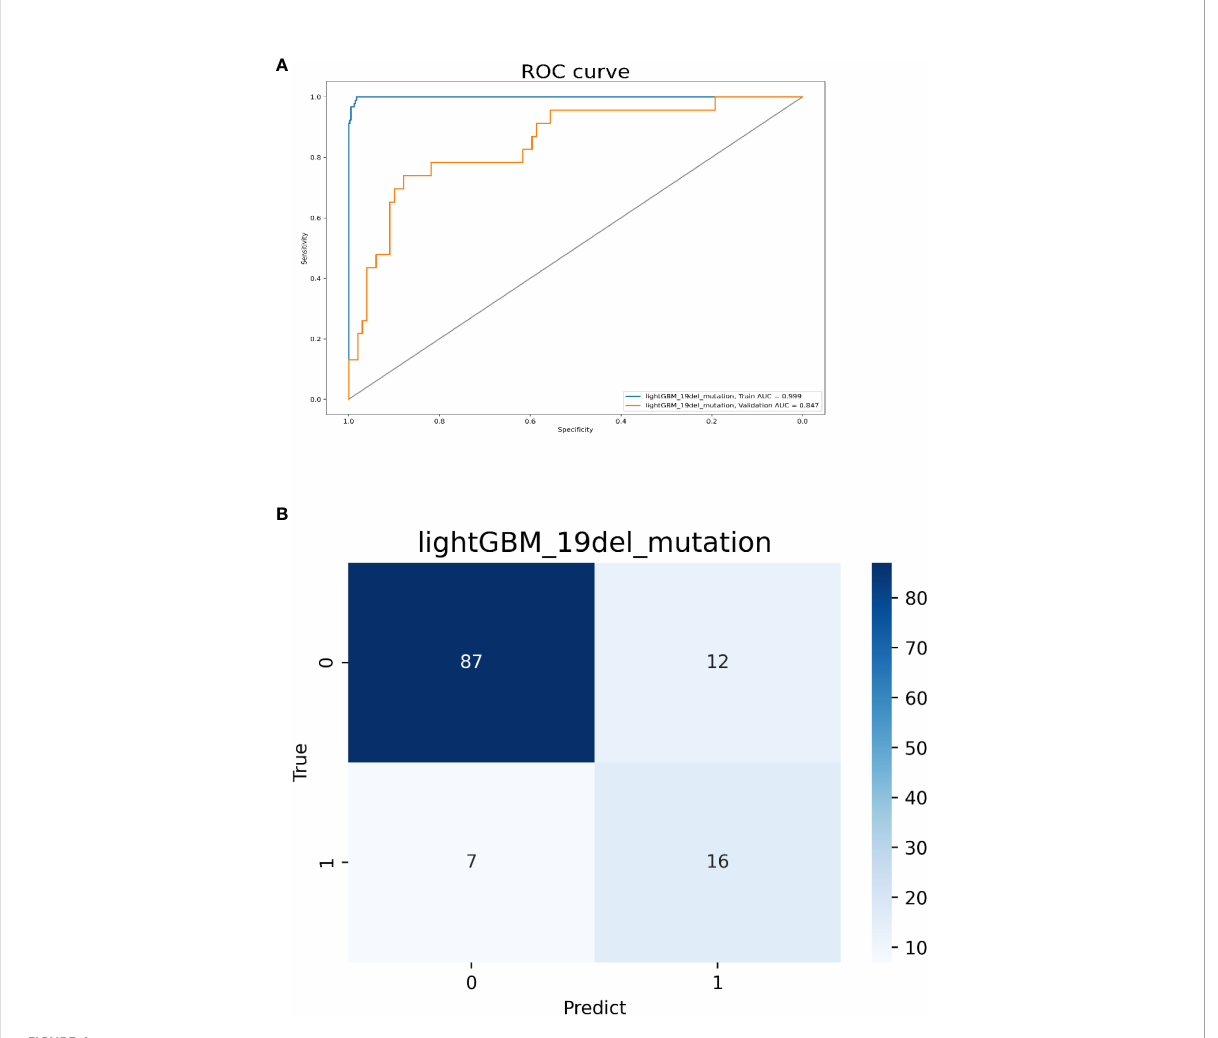
FIGURE 4 Model 2 validation. (A) The ROC curves for model 2 to identify 19del mutations. (B) The confusion matrix for model